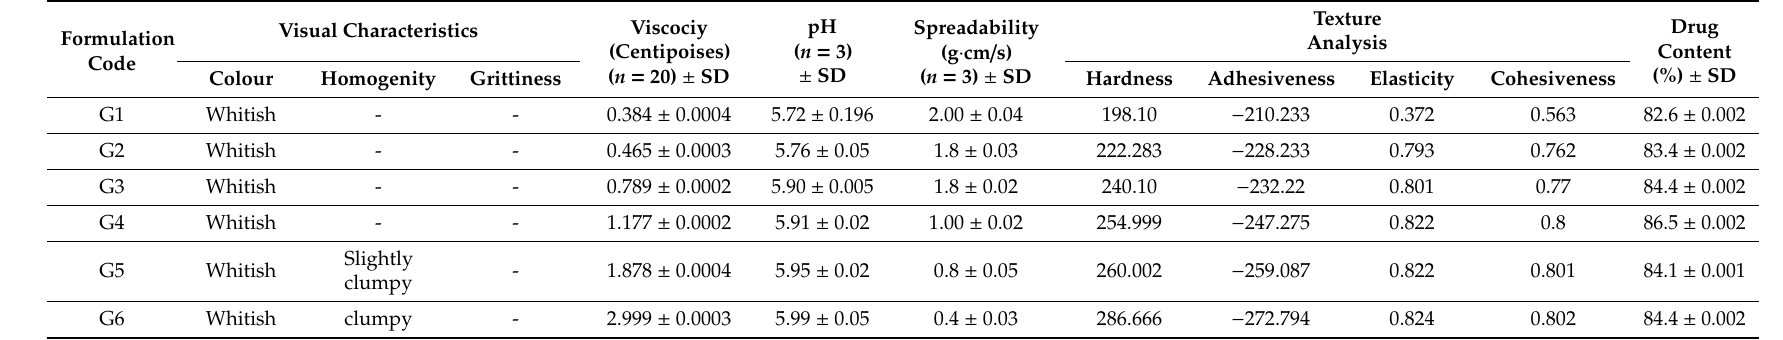
Table 5. Physicochemical characteristics for evaluation of